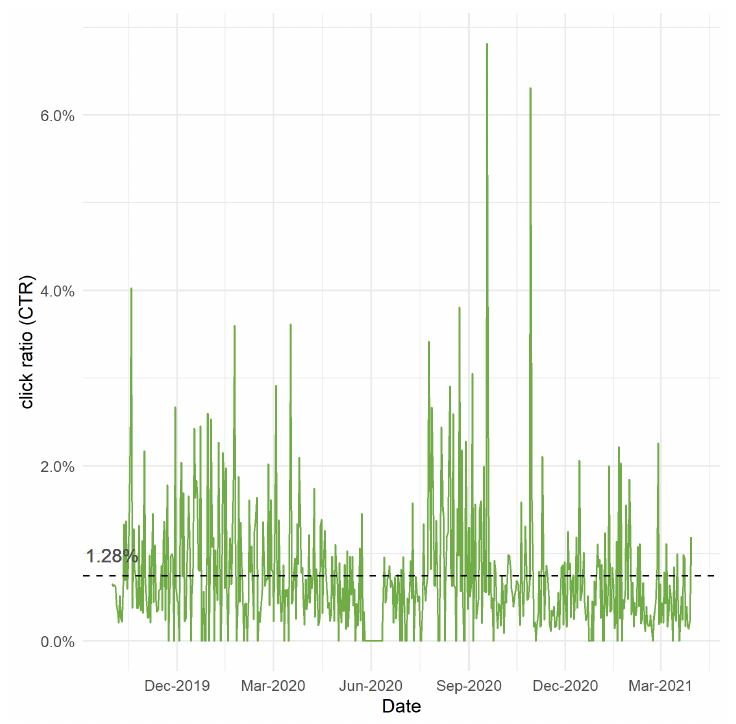
Figure 11. Clicks in recommender (CTR) in production.